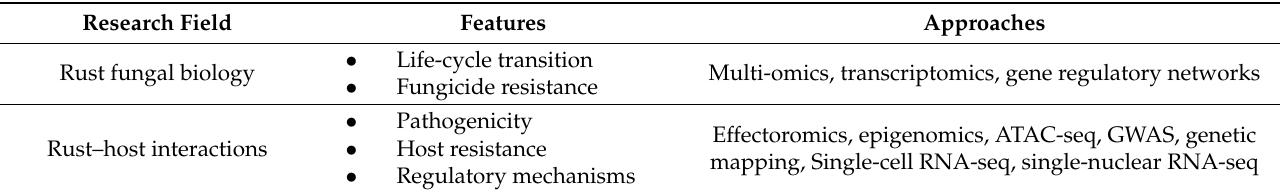
Table 4. Perspectives on genomics research of rust